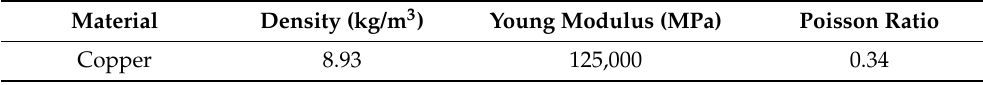
Table 1. Physical and elastic properties of copper [15].